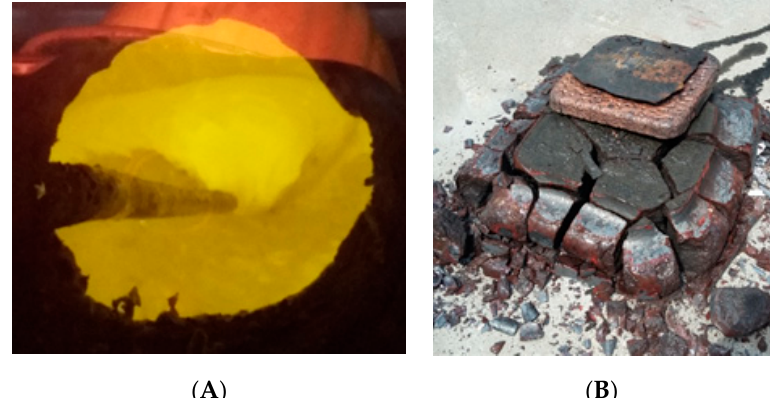
Figure 7. ( A ) Molten slag phase inside the TBRC during the melting process; ( B ) cooled slag and metal block [5]. block [5] .